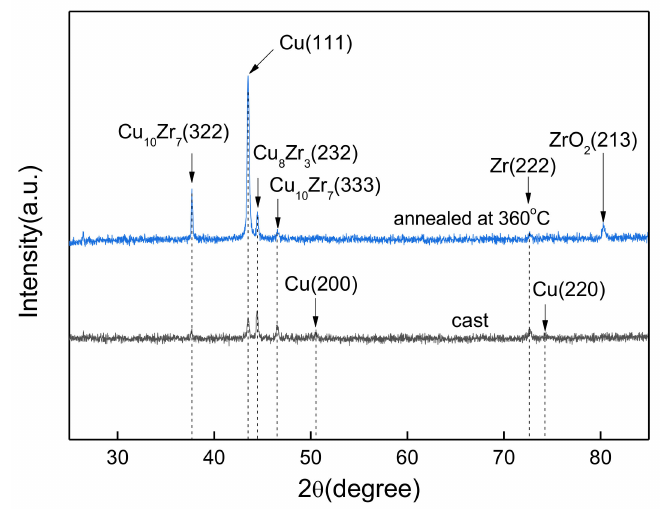
Figure 1. X-ray di ff raction (XRD) patterns of as-cast and annealed Cu-1.1%Zr bulk